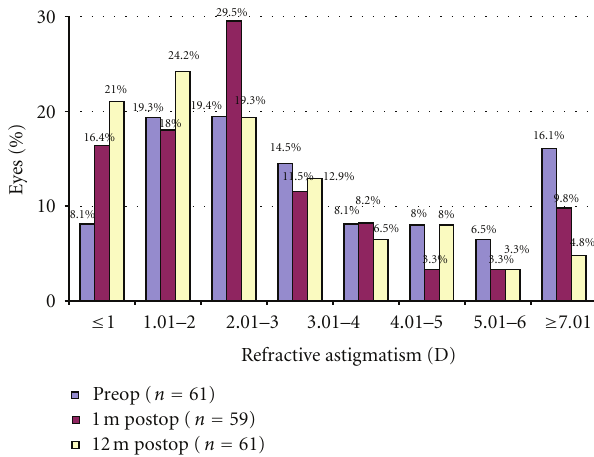
Figure 4: Refractive astigmatism after epithelium-on CXL.